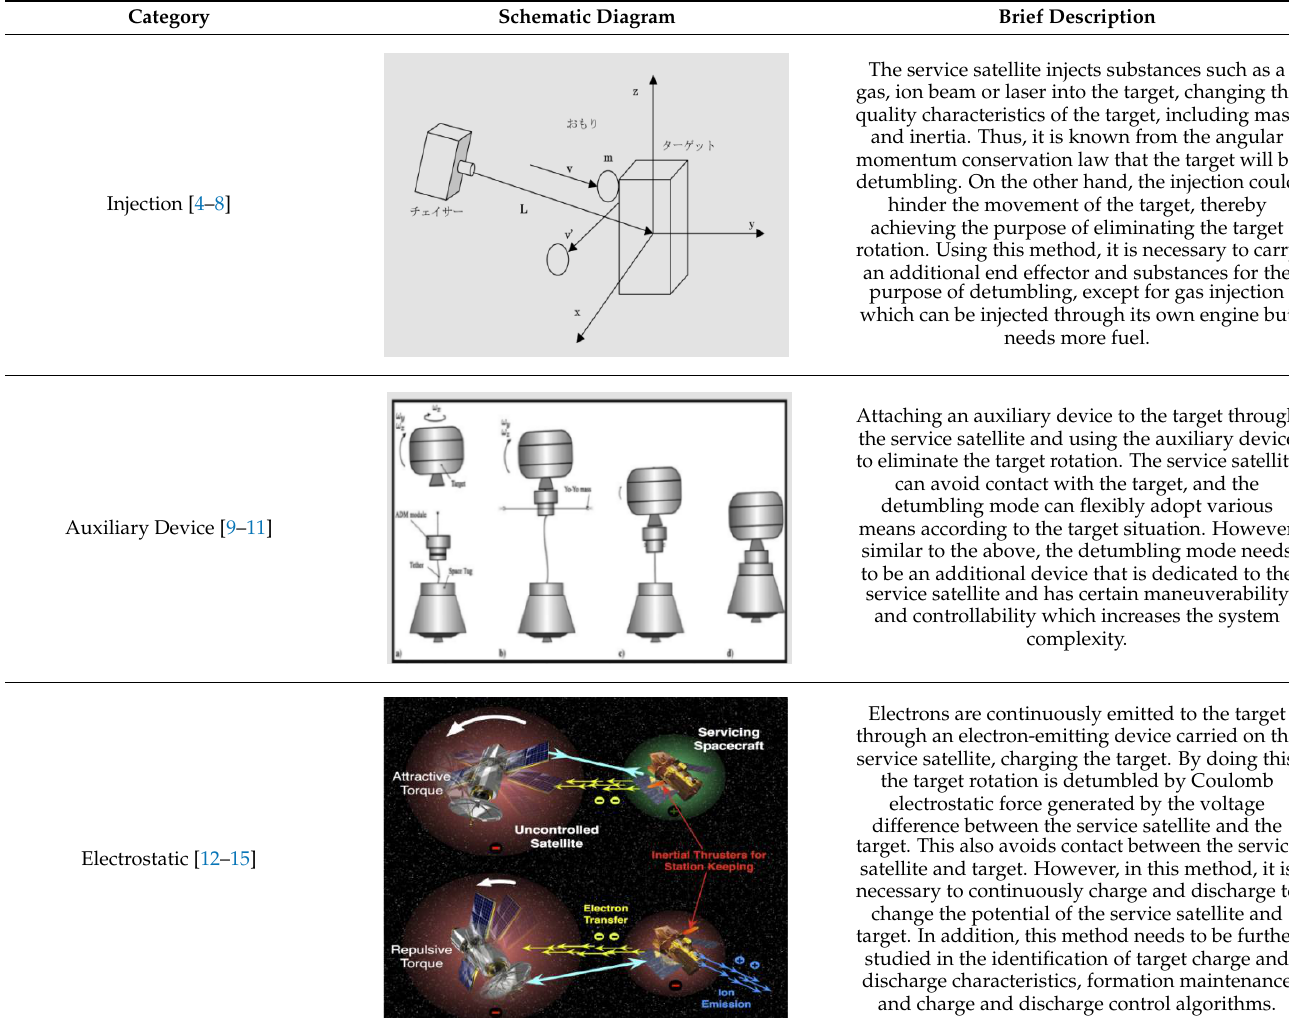
Table 1. Summary of the detumbling methods in recent years.